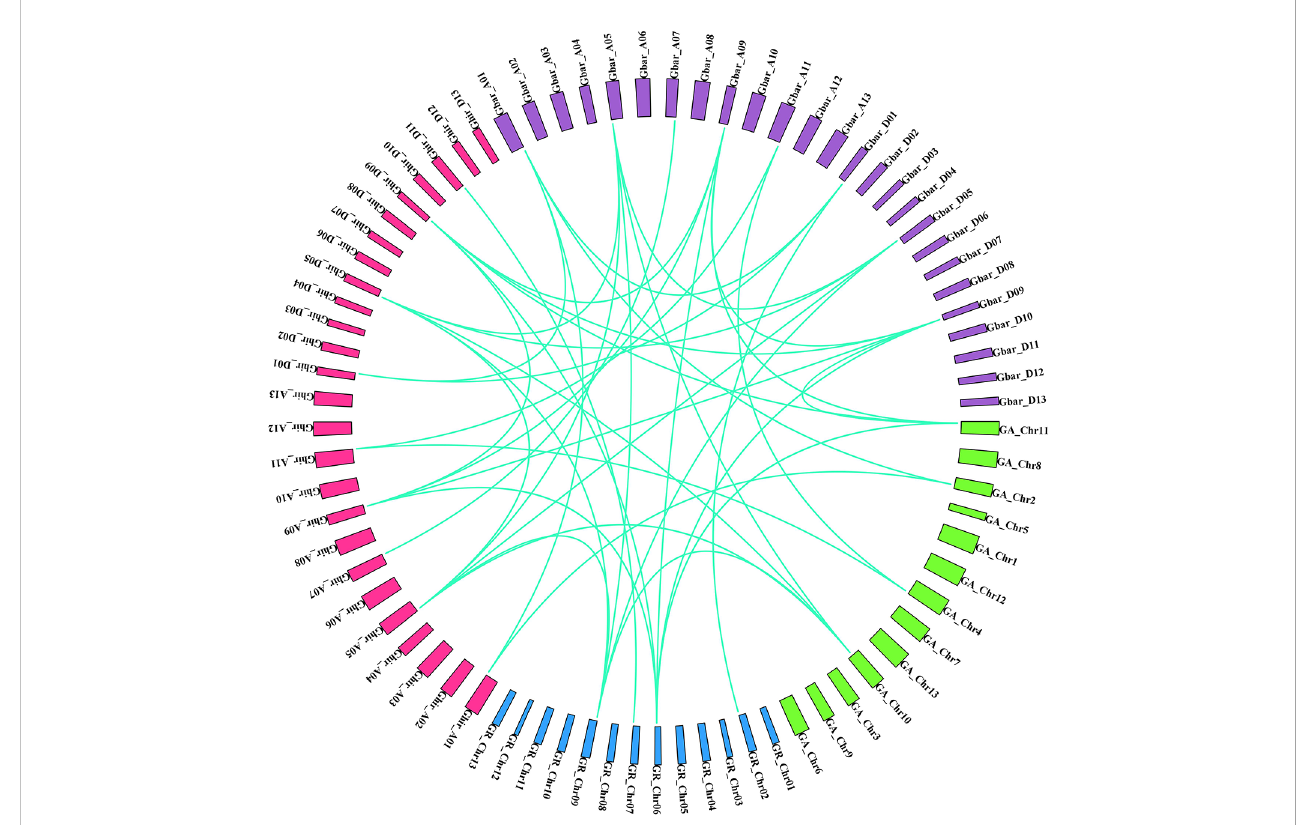
FIGURE 8 Syntenic associations in orthologous HD2 gene pairs in four Gossypium species (green: G. arborium ; blue: G. raimondii ; pink: G. hirsutum ; violet: G. barbadense